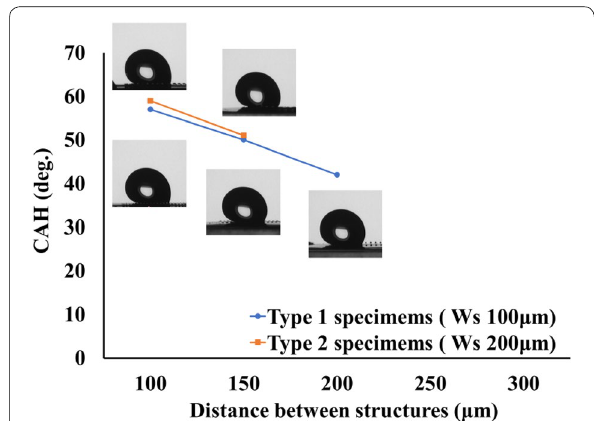
Fig. 6 A plot of contact angle hysteresis (CAH) for Type 1 and Type 2 specimens versus the distance between the parallelogram structures in the acute angle ( D a ) direction